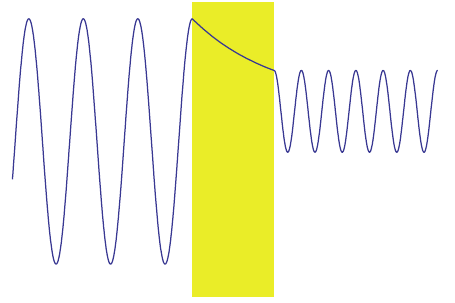
Figure 4: Tunneling probability for a harmonic wave in a potential “barrier” with ̃𝑛 > 𝑛 and length 𝐿